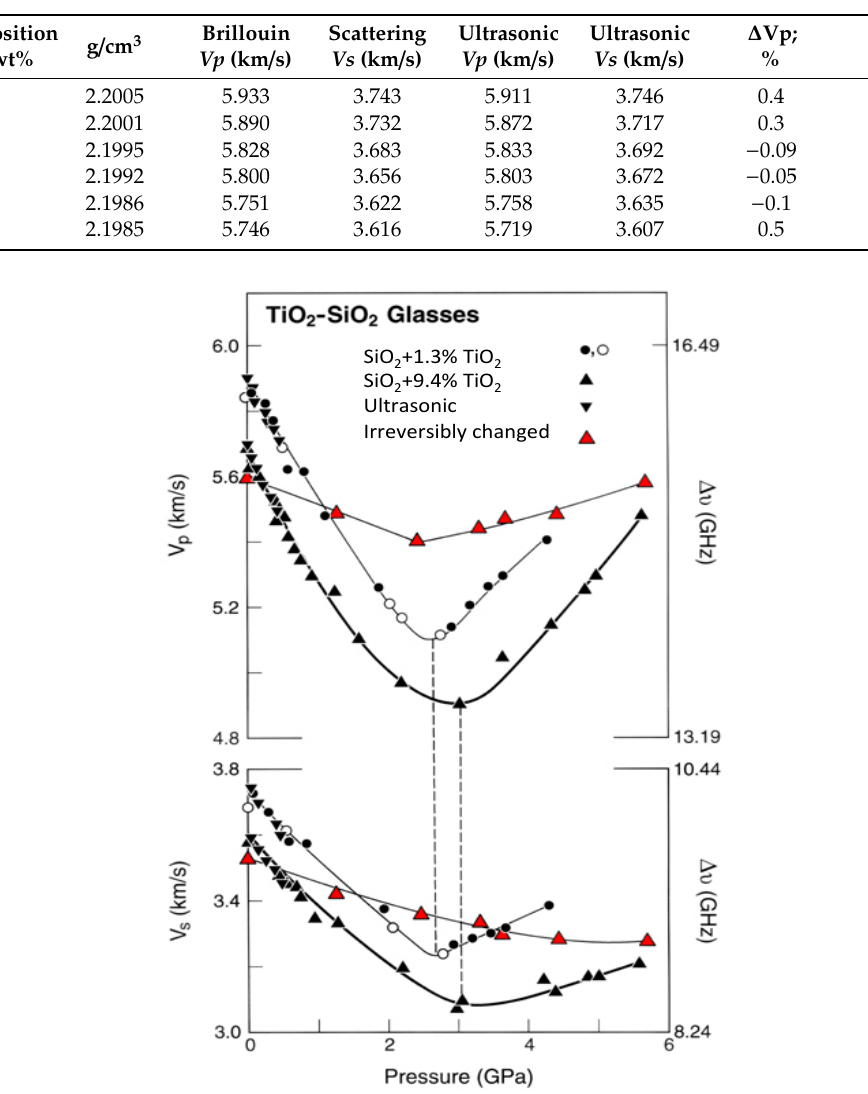
Figure 6. Pressure dependence of the compressional ( V P ) and shear ( V S ) velocities measured by the ultrasonic method up to 0.5 GPa (inverted filled triangles) and Brillouin scattering (triangles, circles) up to ~5.7 GPa for two SiO 2 –TiO 2 glasses. Black filled symbols are compression data and the open are decompression data that have been compressed to pressures below that at which irreversible deformation occurs. Red triangles are decompression points for irreversibly densified glasses compressed to slightly above 5.5 GPa. Error bars for the Brillouin data are in the order of, or smaller than, the size of the symbols; for the ultrasonic data, they are smaller than the symbol sizes. Table 3. Comparison of the ultrasonic and Brillouin scattering measurements of V p and V s in SiO 2 –TiO 2 glasses at ambient conditions.